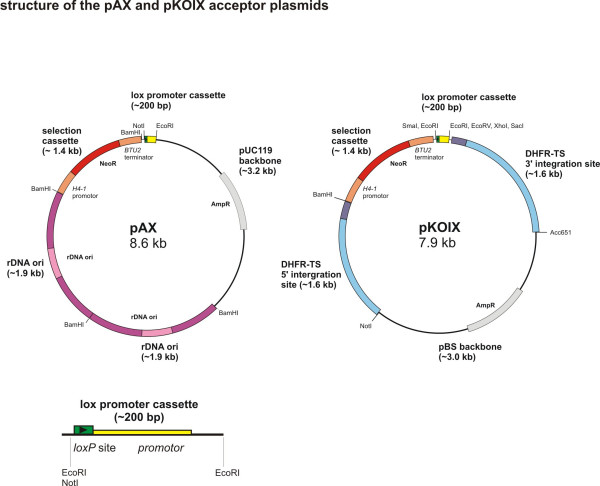
The acceptor vectors pAX and pKOIX. Structure of pKOIX and pAX acceptor plasmids. The loxprom site that consists of a loxP site (green) and the bacterial promoter (yellow) was inserted into pH4T2 by using the NotI and EcoRI and into pKOI by EcoRI restriction sites, respectively. The arrow head in the loxP sites indicates the loxP orientation. The gray/black parts correspond to the backbone sequences that are necessary for propagation in E. coli, and the red part of both acceptor vectors illustrate the neo2 selection cassette for selection in T. thermophila by paromomycin. The purple colored part of pAX illustrates the AT-rich double rDNA ori which is necessary for the propagation in T. thermophila. The blue part in pKOIX shows the AT-rich 5' and 3' integration sequences (bright blue, up/downstream and dark blue coding sequences). They are part of the endogenous DHFR-TS gene locus.(Bottom: detail of loxprom site).